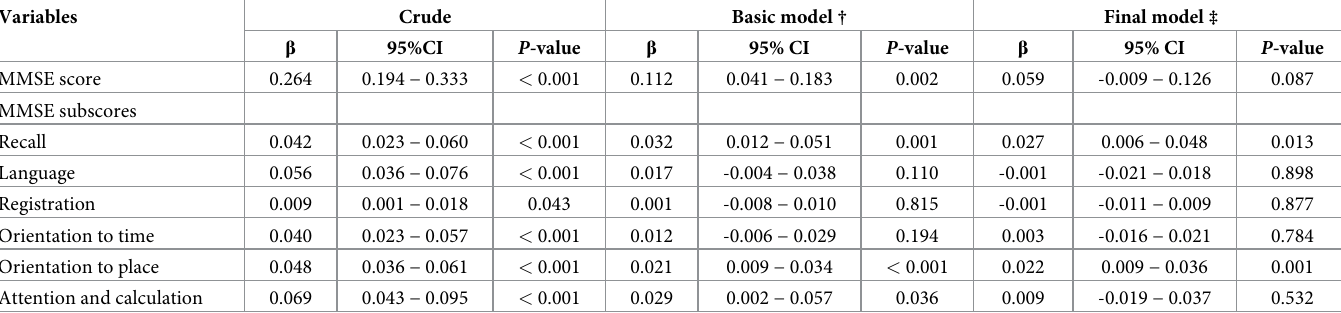
Table 5. Multivariate linear regression analysis of the association between calf circumference and cognitive domains. Variables